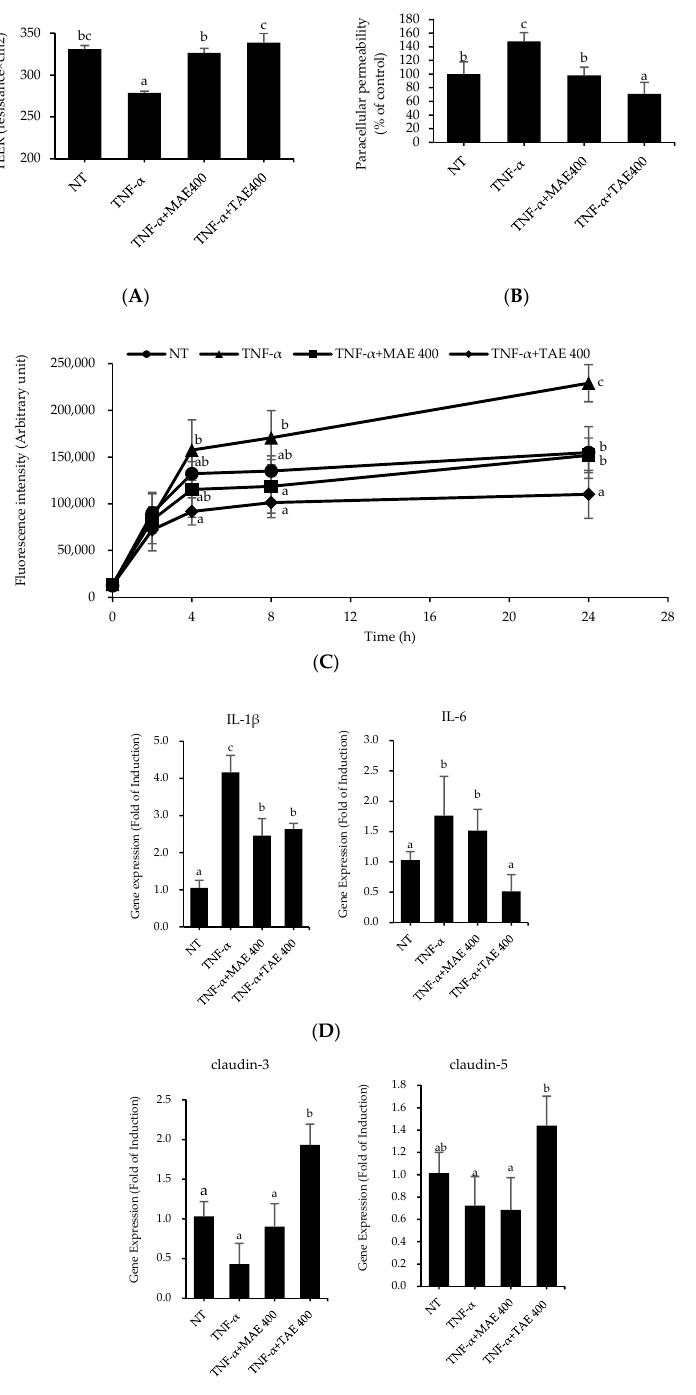
Figure 1. Caco-2 monolayers were apically pre-treated with mature apple extract (MAE) and thinned apple extract (TAE) for 1 h in the apical compartment and then incubated with 100 ng/mL of tumor necrosis factor-alpha (TNF- α ) in both apical and basolateral compartments for 24 h. Tight junction integrity was determined by ( A ) the transepithelial electrical resistance (TEER) value and ( B ) paracellular permeability at 24 h. ( C ) The time course of paracellular permeability was tested in TNF- α treated Caco-2 cells with/without MAE and TAE. Gene expression levels were estimated by quantitative RT-PCR analysis of ( D ) interleukin-beta (IL-1 β ) and IL-6, and ( E ) claudin-3 and claudin-5. 18S gene expression was measured as a loading control. Results are shown as mean ± SEM ( n = 3–6). Different letters indicate significant differences by Duncan’s multiple range test ( p < 0.05).